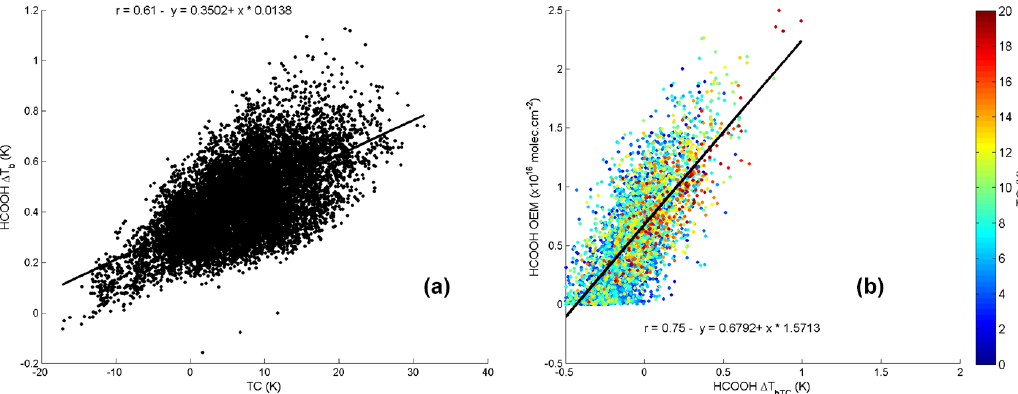
Figure 4. (a) Scatter plot of the simulated (cid:49)T b and the TC for one fixed HCOOH total column (0 . 6 × 10 16 moleccm − 2 ). (b) Scatter plot between the HCOOH retrieved total columns using the optimal estimation method and the corrected HCOOH (cid:49)T bTC . (cid:49)T bTC corresponds to the HCOOH (cid:49)T b taking account the TC dependence, given by the equation in panel (a) . Each data point is colored based on its thermal contrast value as in Fig.